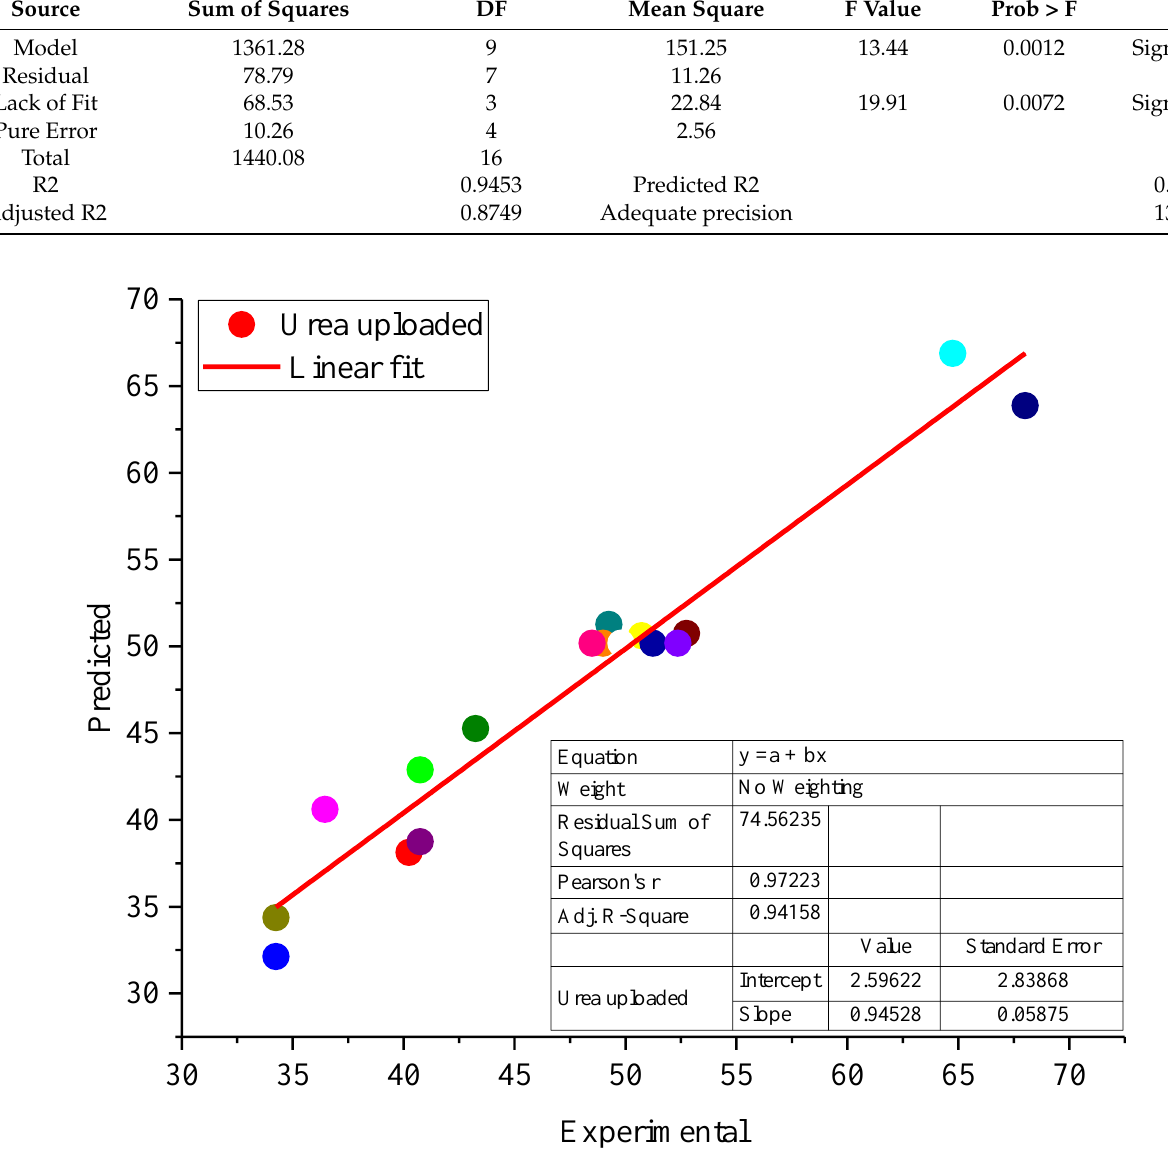
Figure 9. Plot shows the experimental and expected values of the urea uploaded in the urea/gelatin film under the interaction of the independent